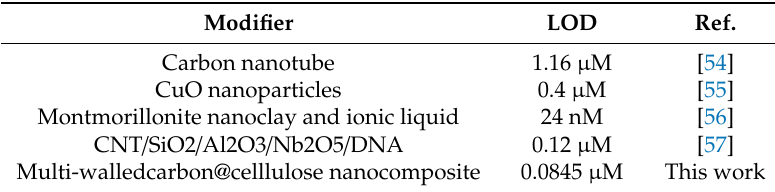
Figure 7. ( A ) Di ff erential pulse voltammograms for increasing concentration of AMT ( µ M): (1) 0.5 (2) 7.5 (3) 10.0 (4) 15.0 (5) 20.0, other conditions are same as above. ( B ) Plot of current against the concentration of AMT. Table 2. of detection limits for AMT to di ff erent electrode